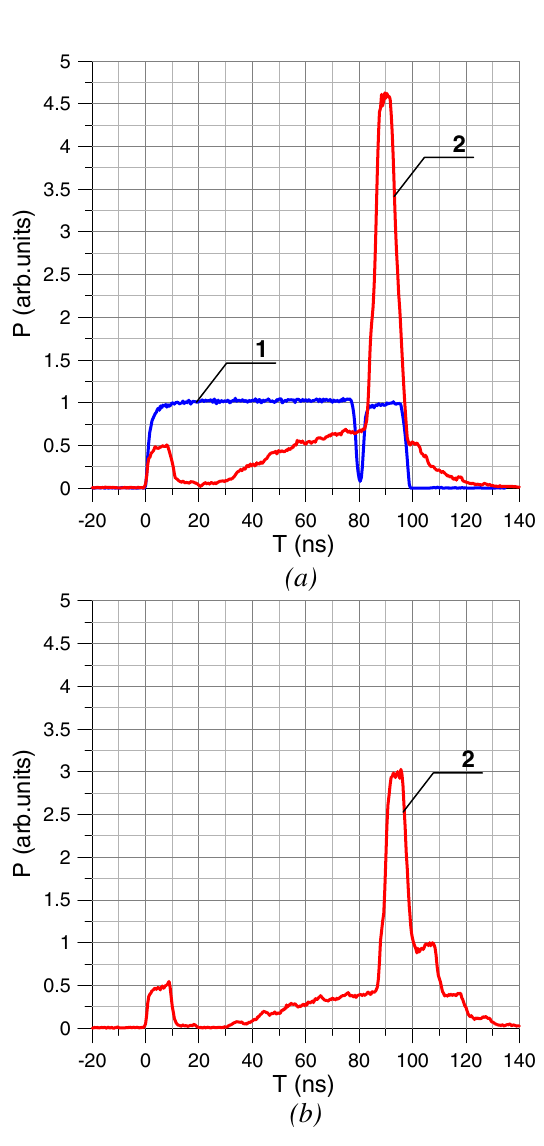
FIG. 16. (Color) Oscillograms of the incident (curve 1) and compressed (curve 2) pulses in a case of 180 (cid:7) phase flip: (a) f (cid:1) (cid:1) 6 : 5 , G (cid:1) 4 : 5 ; (b) f (cid:1) 29 : 6 GHz , C 30 GHz , C r